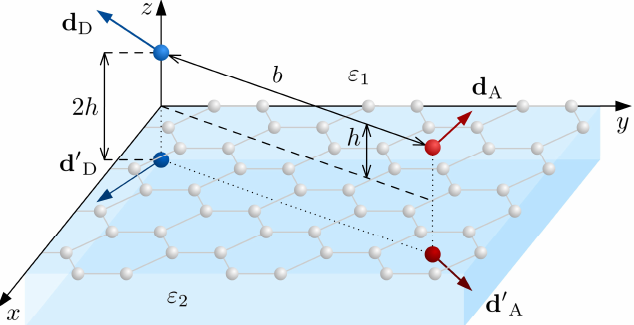
Figure 9. Schematics of two QDs on top of a graphene sheet, interacting via their real transient dipoles and image dipoles representing transient charge distributions in the graphene